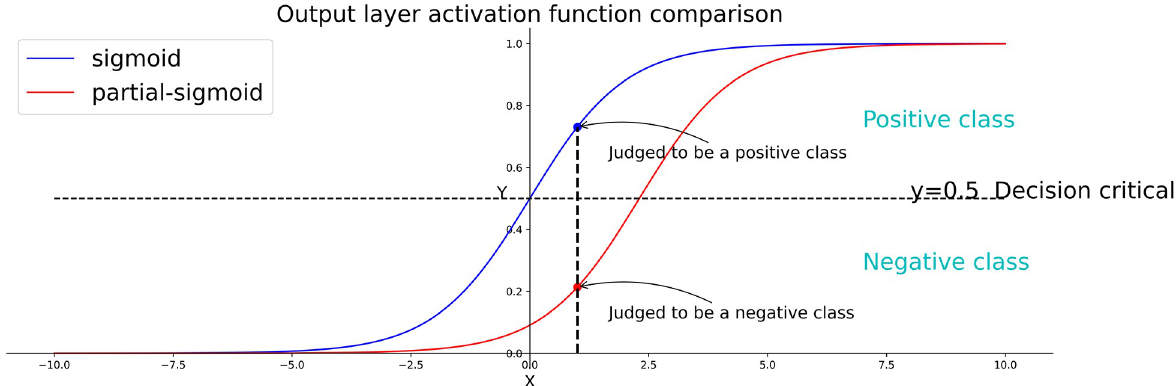
Fig 2. Decision comparison between the sigmoid and partial-sigmoid functions.